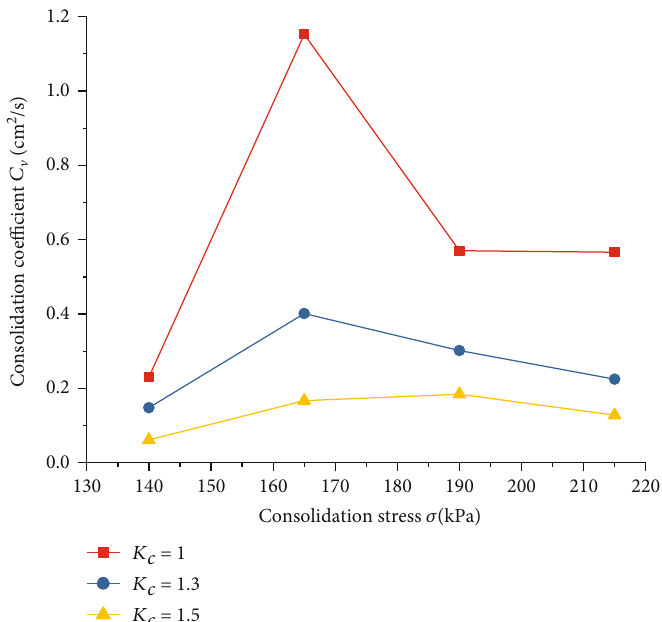
Figure 8: The curve of consolidation coe ffi cients of normally consolidation clay with consolidation pressure at di ff erent consolidation stress ratios.